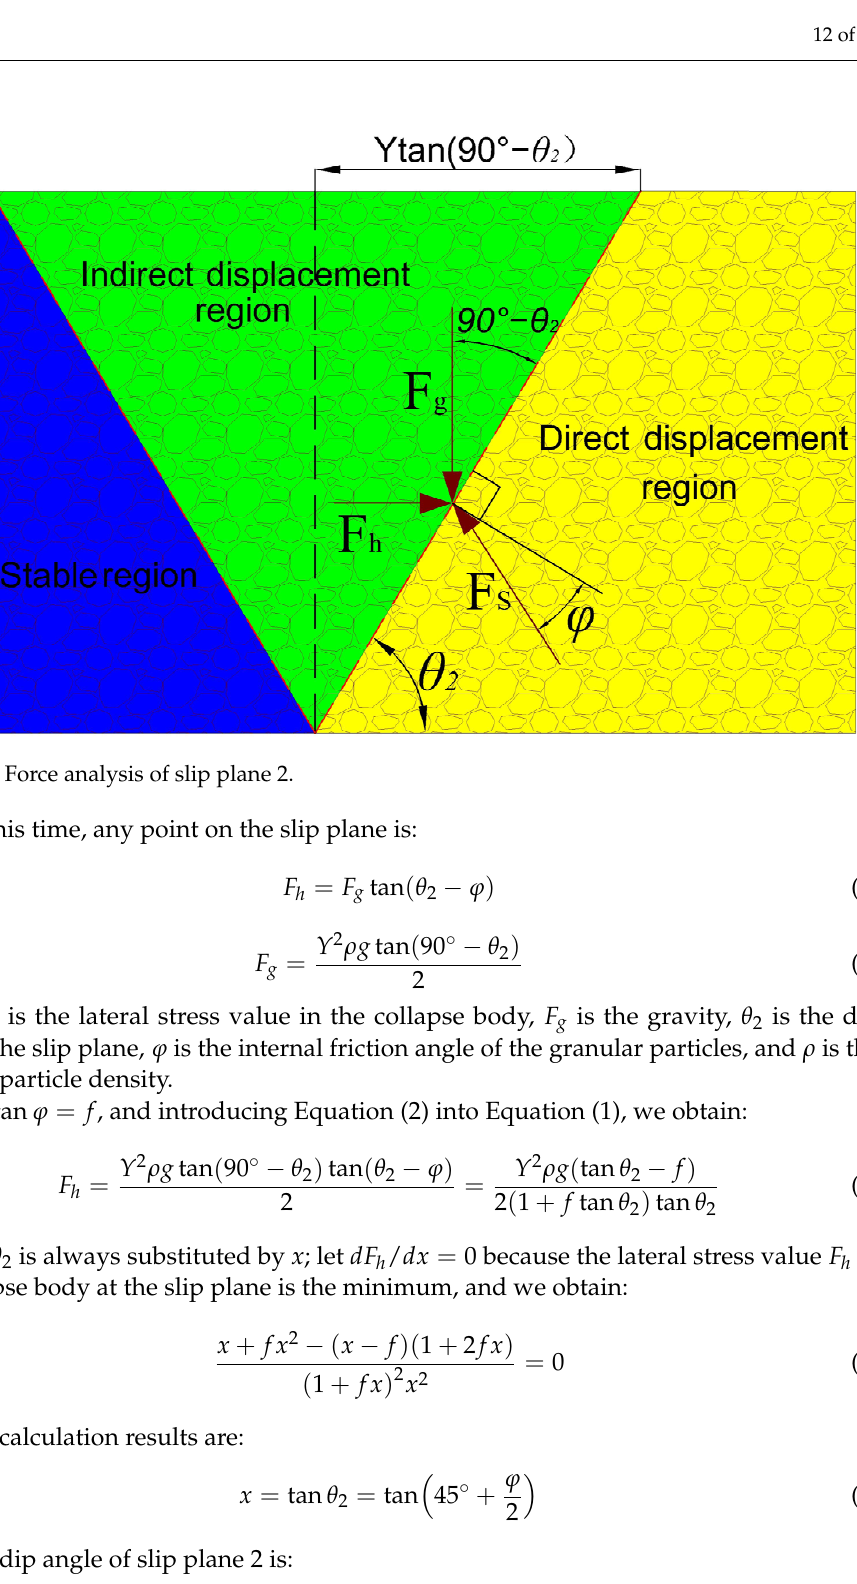
Figure 10. Boundary stress curve.